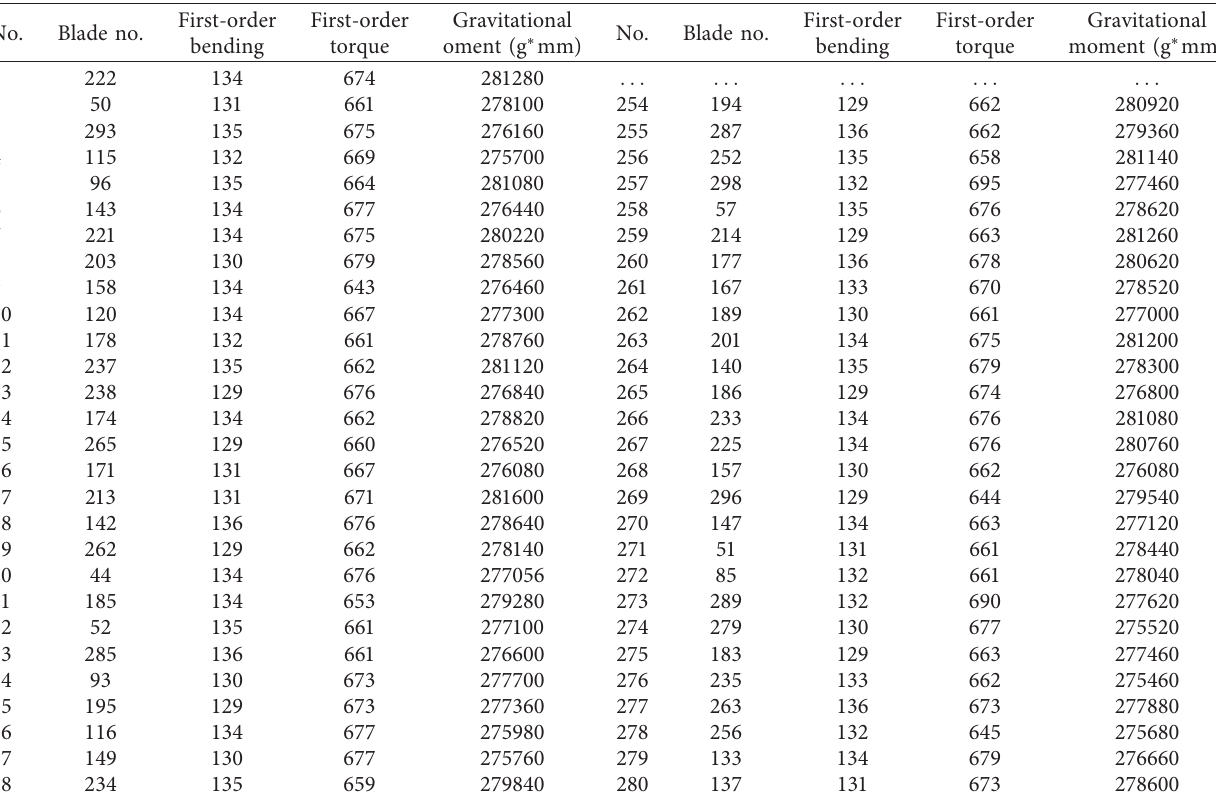
Table 3: Ten groups of rotating blades (280 blades) selected from the blade database.